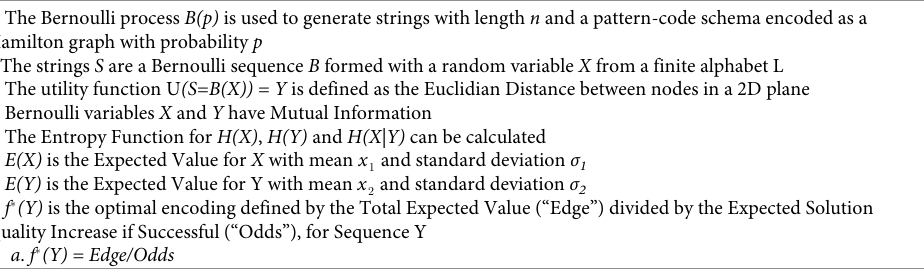
Table 10. Auxiliary theorems for the proposed model based in information